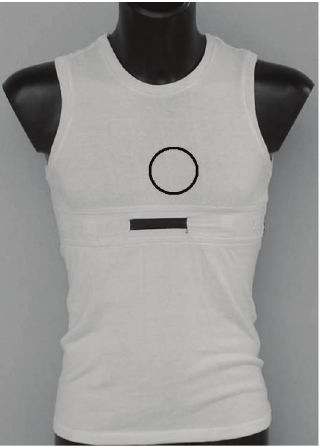
Figure 2: Prototype of the inner garment in which the wearable wireless interface for the detection of the heart and breath rates will be included. In detail, the sensor will be placed around the circled